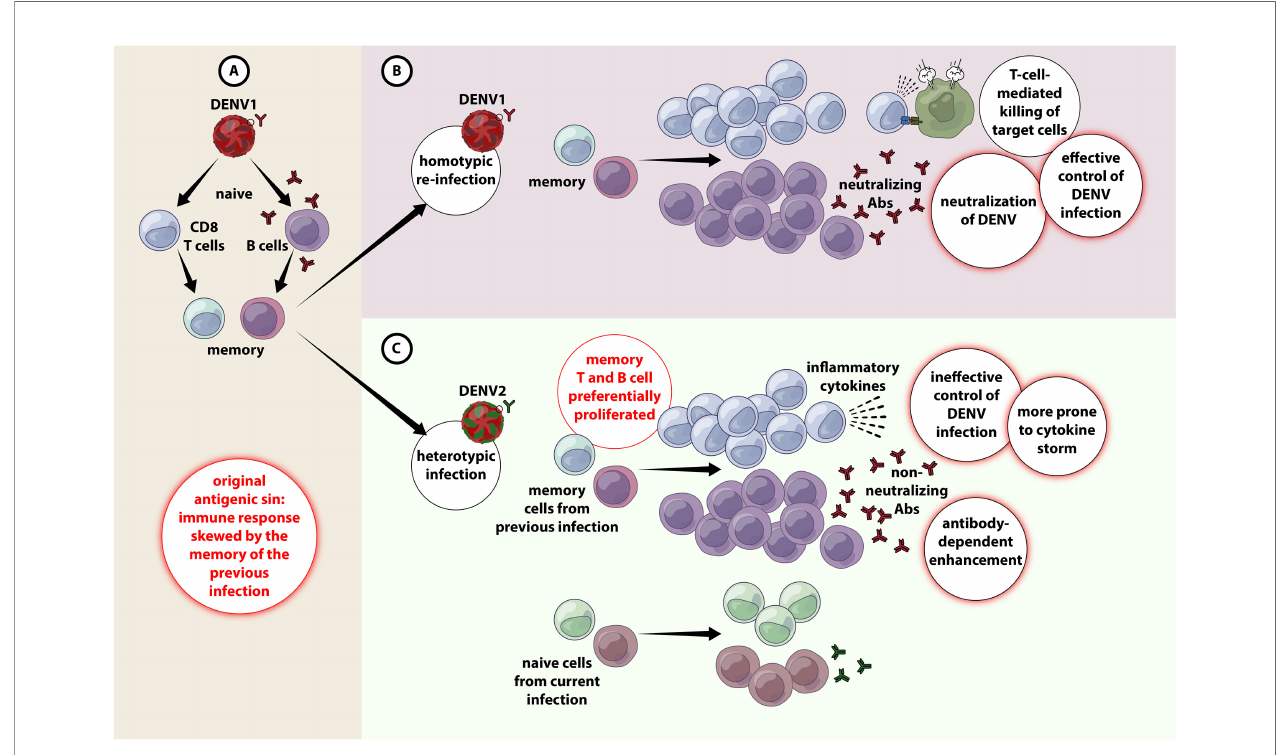
FIGURE 1 | Original antigenic sin and antibody-dependent enhancement in DENV infection. (A) When primary infection occurs with e,g. DENV1, resulting in activation of adaptive immune responses (both T and B cells) DENV1-speci fi c T cells are selected, activated, and clonally expanded to combat infection. Upon termination of primary infection, memory DENV1 – speci fi c T cells and B cells are formed and are retained with higher frequency compared to other naïve cells. (B) A secondary infection with the same serotype of DENV (e.g. DENV1) for the second time (homotypic infection), the virus will evoke a memory response that entails in the effective containment of DENV1 by highly speci fi c T and B cell responses. (C) A secondary challenge with a different serotype of DENV (e.g. DENV2) (heterotypic infection), there is a chance that the cross-reactive memory T and B cells get preferentially activated, proliferated over the DENV2-speci fi c T and B cells. The cross- reactive DENV1 – speci fi c adaptive immune responses outcompete naïve T cells that would be more speci fi c for DENV2, resulting in an expanded memory T cell pool that is of low speci fi city for DENV2 and poor viral clearance. Antibody-dependent enhanced replication also has the potential to occur during a secondary, heterologous